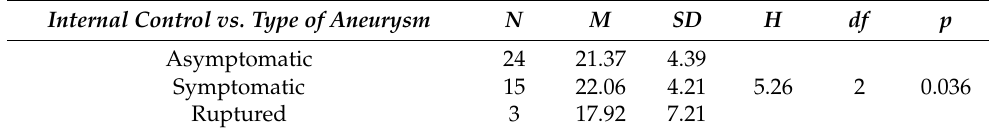
Table 3. Internal control vs. type of aneurysm.